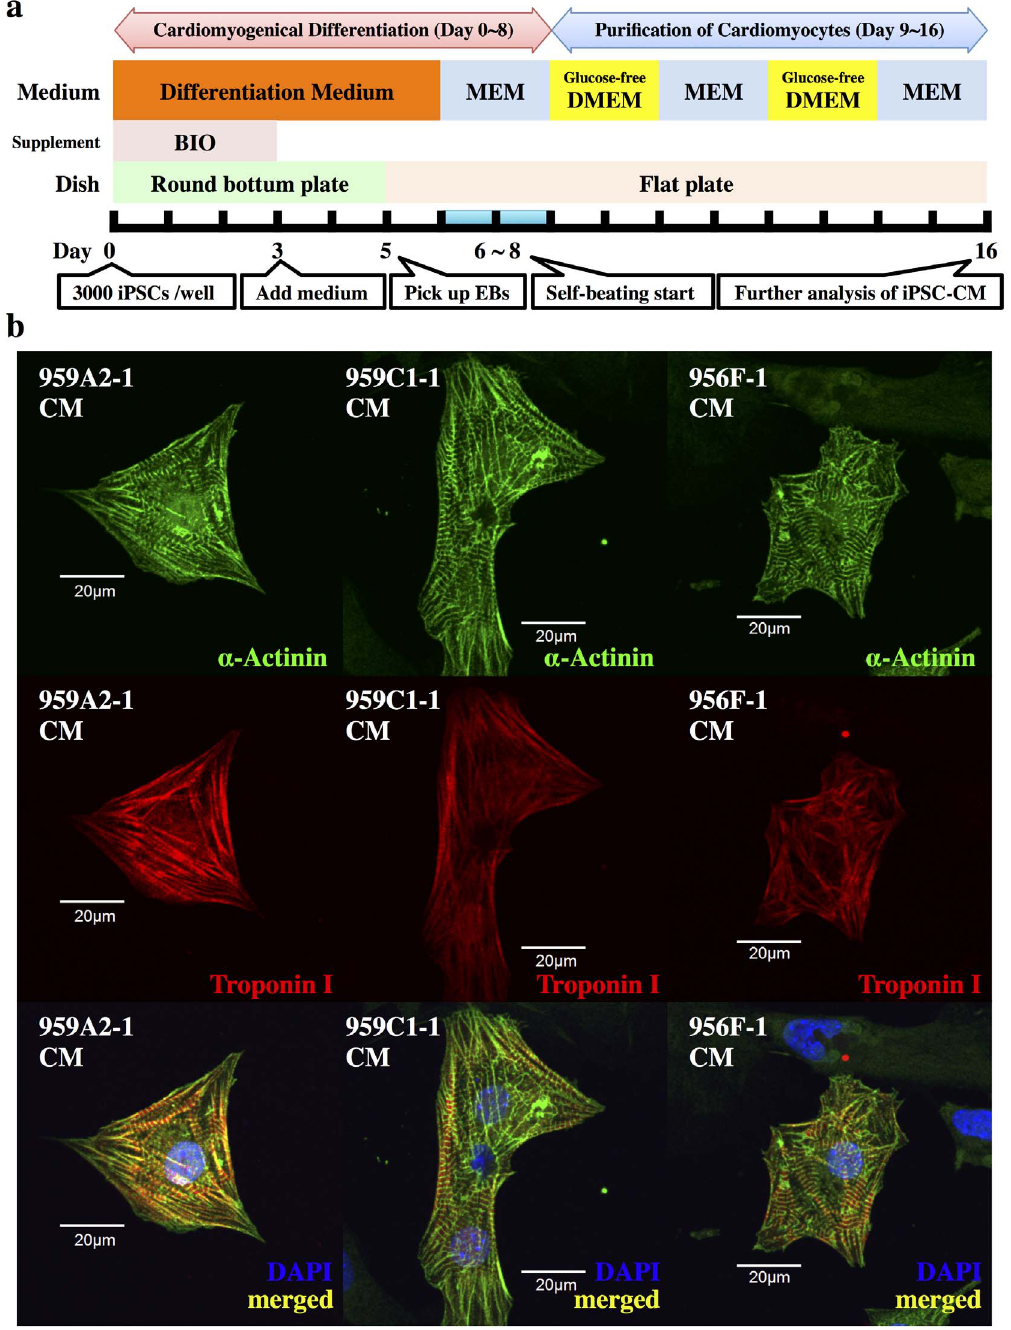
Figure 1. Cardiomyogenic differentiation of iPSCs and cardiomyocyte purification. (a) The cardiomyogenic differentiation protocol and cardiomyocyte purification process are illustrated. (b) IPSC-CMs stained with anti- a -actinin antibody (Alexa Fluor 488), anti-troponin I (Alexa Fluor 594) and DAPI, were analyzed with a confocal laser scanning microscopy. Abbreviations: EB, embryonic body; MEM, Modified Eagle’s Medium; DMEM, Dulbecco’s Modified Eagle’s Medium; BIO, 6-bromoindirubin-3 9 -oxime. change during the course of cardiomyogenic differentiation of iPSCs in vitro . We analyzed N -glycan expression in undifferen- tiated iPSCs, iPSC-CMs, and adult murine myocardium by HPLC, to identify potential indicators of the maturity of differentiating cardiomyocytes from iPS cells in vitro .